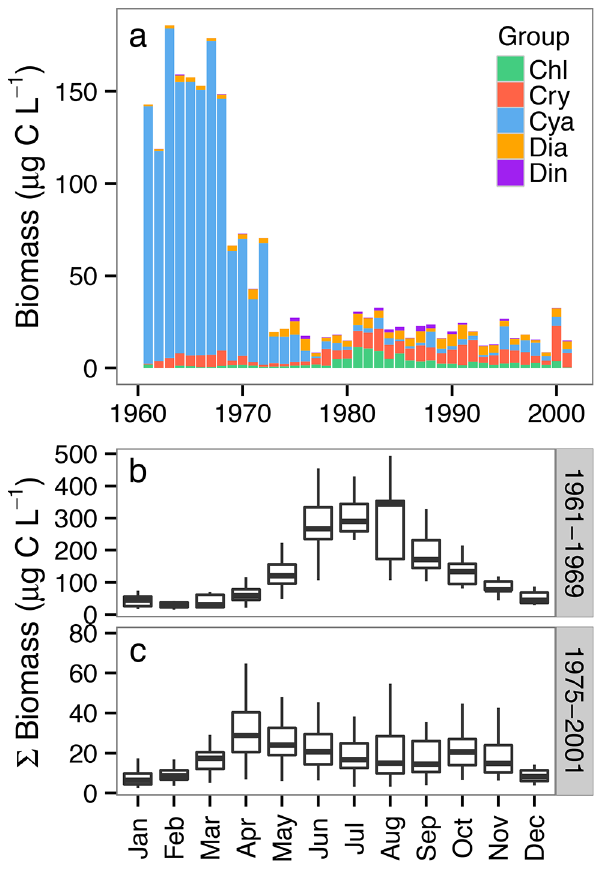
Fig 5. Lake Washington annual and monthly phytoplankton biomass from 1961 – 2001. (a) Stacked barplots of annual average phytoplankton biomass, color-coded by taxonomic group, from 1961 – 2001. Boxplot of average total phytoplankton biomass during the (a) eutrophic years (1961 – 1969) prior to sewage treatment, and (b) the oligotrophic years (1975 – 2001) after the transition (1970 – 1974) to sewage treatment in Lake Washington. Abbreviations follow Fig